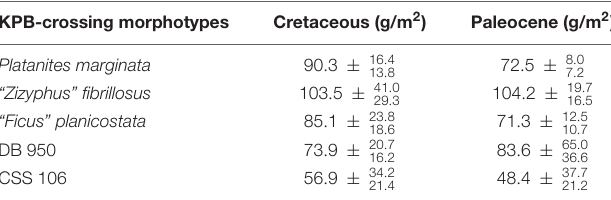
TABLE 1 | Estimated mean leaf dry mass per area (LMA) of boundary crossing morphotypes found on both sides of the Cretaceous—Paleogene boundary